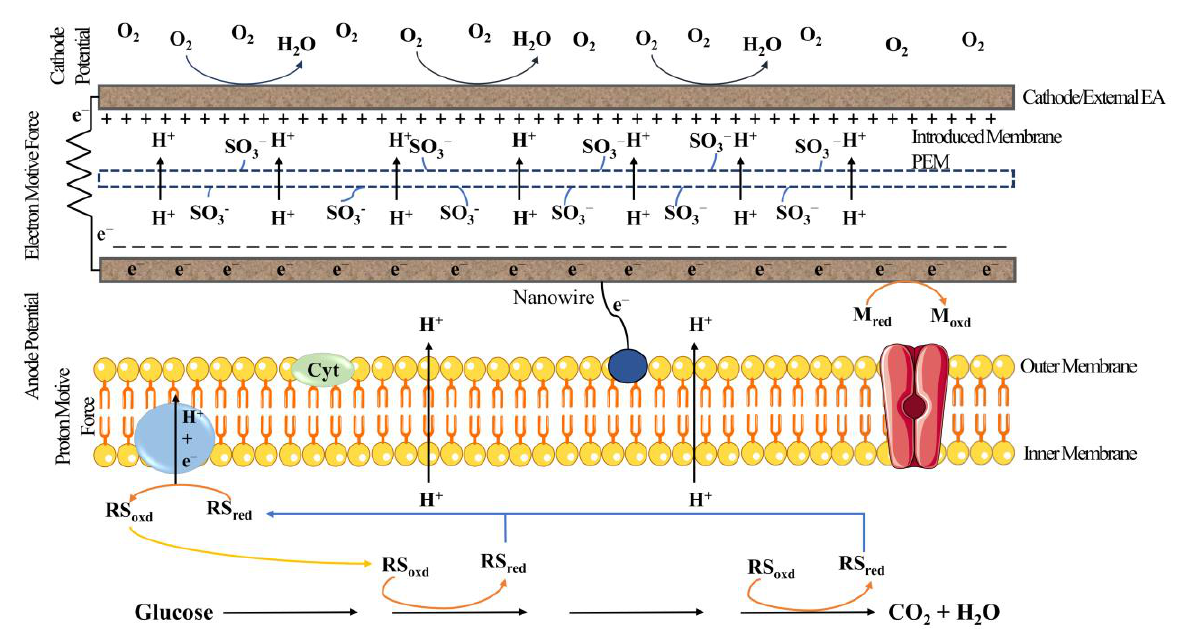
Figure 4. Illustration depicting proton and electron generation via exoelectrogens and proton trans- portation across the PEM membrane in MFCs.